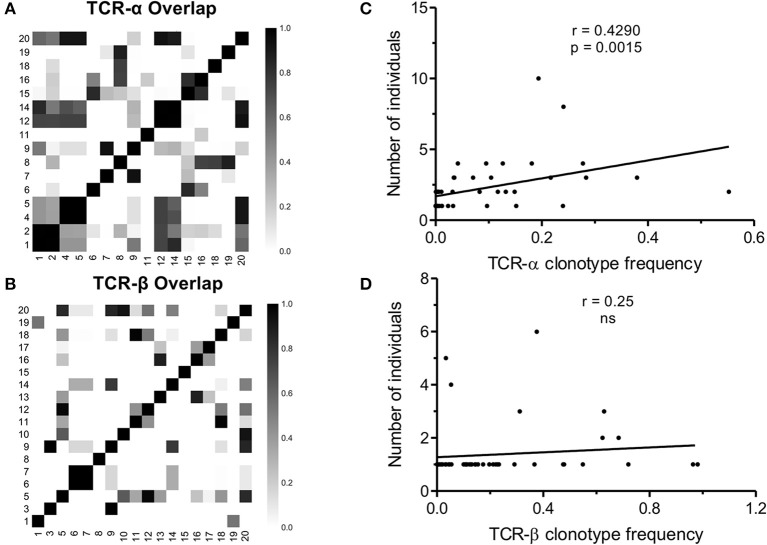
TCR sharing amongst NW8-specific CD8+ T cells from CMV-infected individuals. Compositional similarity amongst (A) TCR-α and (B) TCR-β chains was assessed using the Morisita-Horn (CMH) index and illustrated as a heat map. Patient numbers are shown along the x and y-axes. CMH values range from 0 (no overlap) to 1 (perfect overlap). The average frequency of a given clonotype is plotted against the number of individuals sharing that clonotype, for (C) TCR-α chains (n = 53) and (D) TCR-β chains (n = 51). Spearman's rho and p-values are shown above each graph.